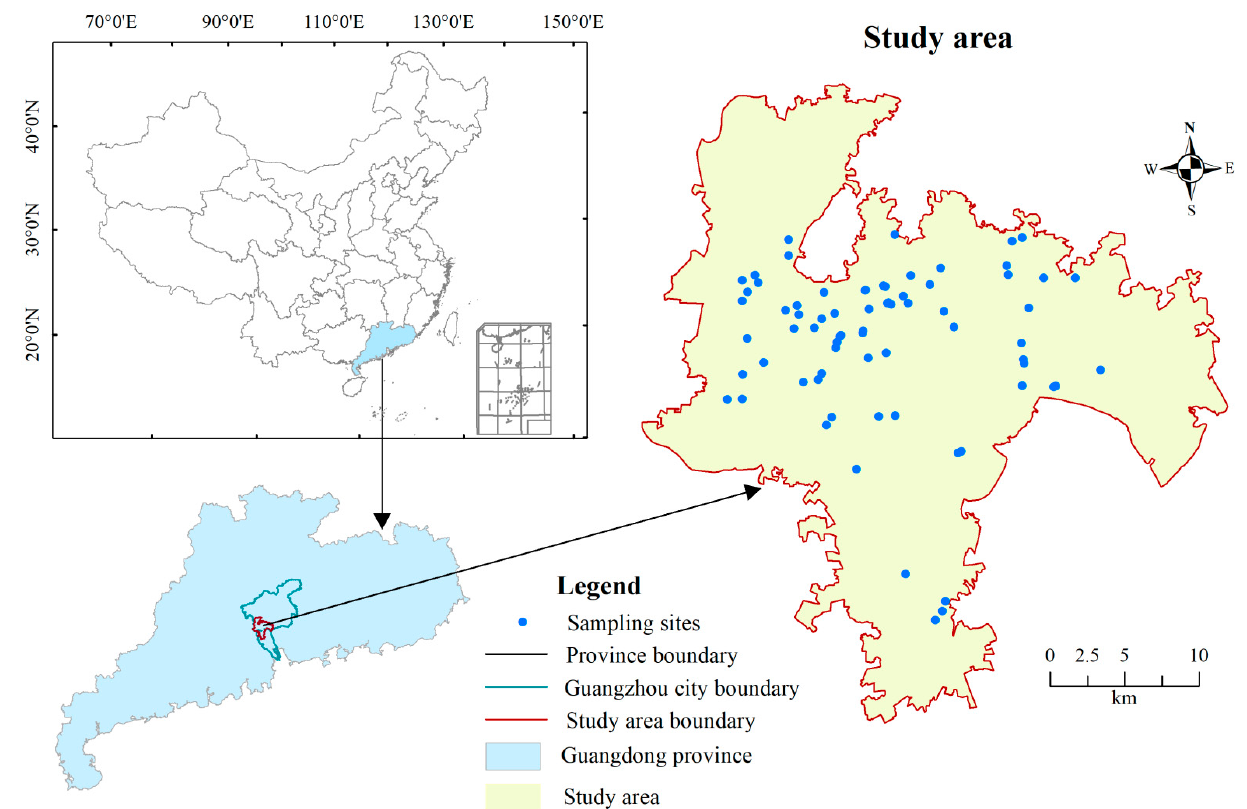
Figure 1. Location of Guangzhou city and sampling site distribution.